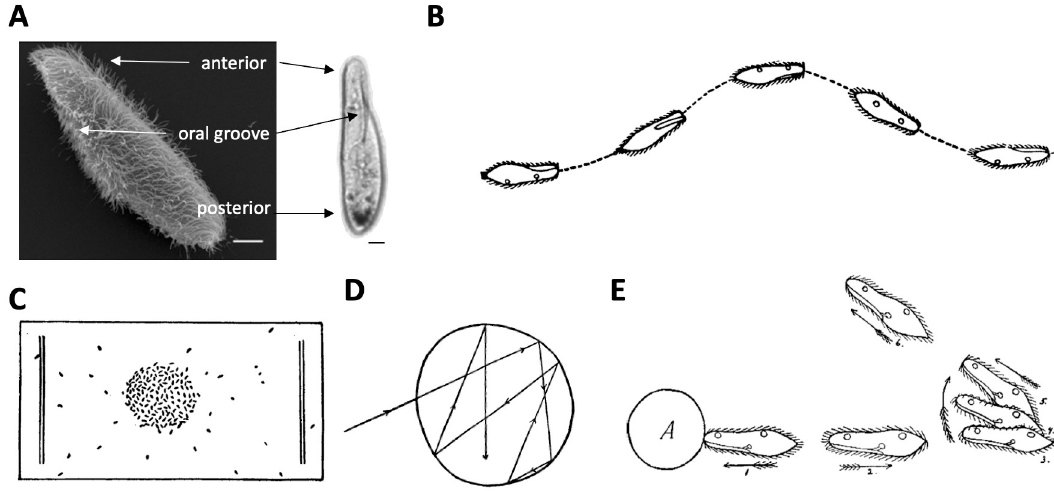
Fig 1. Presentation of Paramecium. A, Scanning electron microscopy image (left) [12], and bright field microscopy image (right) of Paramecium tetraurelia (scale bars: 10 μ m). B, Typical helicoidal swim of Paramecium [13]. C, Accumulation of paramecia in a drop of acid [13]. D, Trajectory of a single cell in the acid drop, showing directional changes at the boundary [13]. E, Avoiding reaction against an obstacle, showing ciliary reversal followed by reorientation